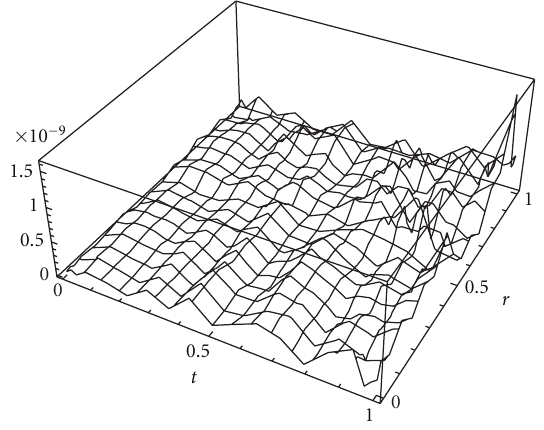
Figure 29: Absolute error of G